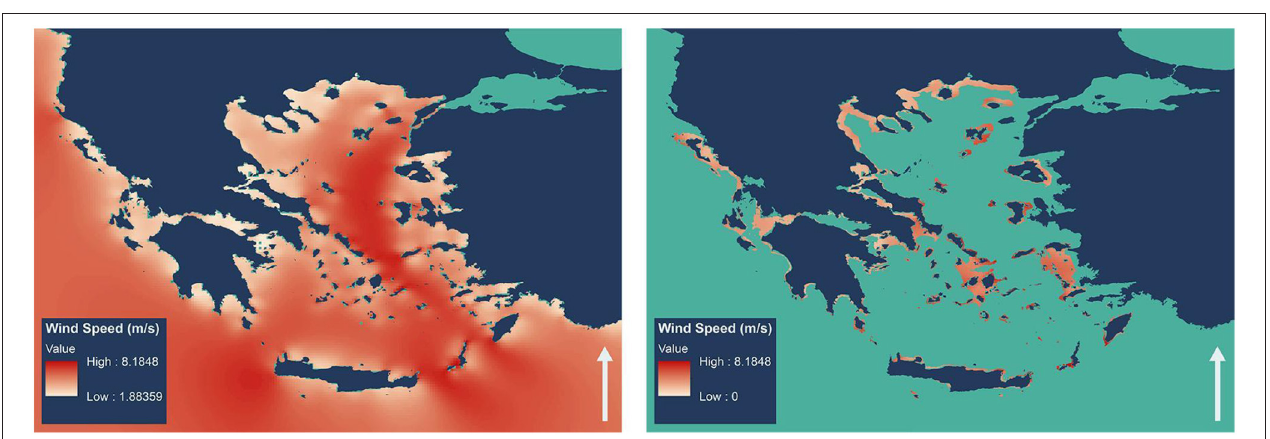
FIGURE 5 | Wind Energy potential in Greece. (Left) Potential in the whole Greek territory. (Right) Areas of exploitable potential focused on sites with proper bathymetry, out of nature protected areas and within greek territory sea (Maestrale WEBGIS, 2018). Further editing by overlapping the layers referred in open source vector